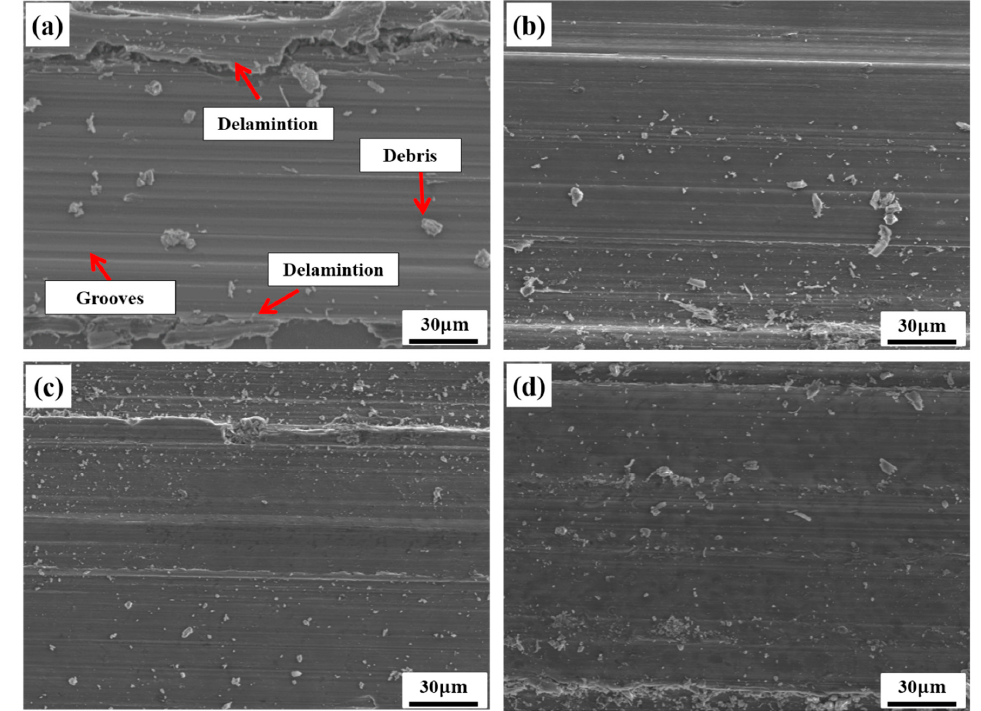
Figure 11. SEM images of the worn surface of AZ31 and its composites: ( a ) AZ31, ( b ) 0.5GNPs/AZ31, ( c ) 1.0GNPs/AZ31, and ( d ) 2.0GNPs/AZ31.